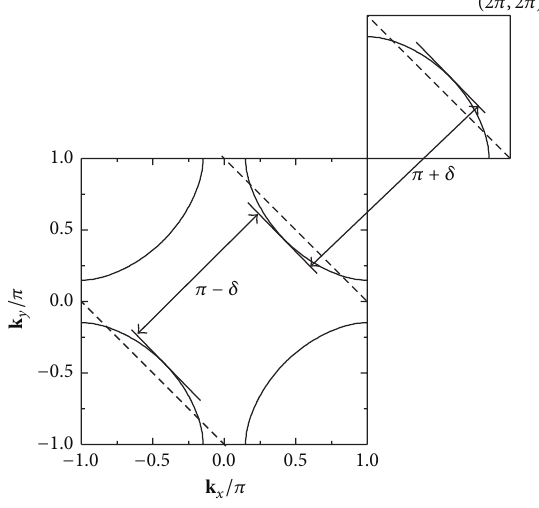
Figure 3: The normal state Fermi surface ( 𝜀 k = 0 ). The diagonal nesting wave vectors are